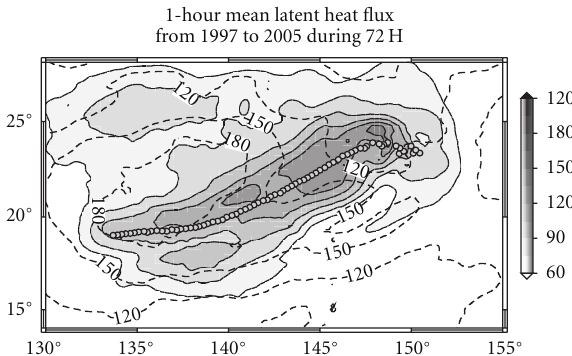
Figure 8: Horizontal distributions of mean latent heat flux (Wm − 2 ) during 72 h among the nine NCM predictions (contours) and of its standard deviation (shading). Latent heat flux values instantaneously calculated every hour were used. Hai-tang’s best track is also shown.